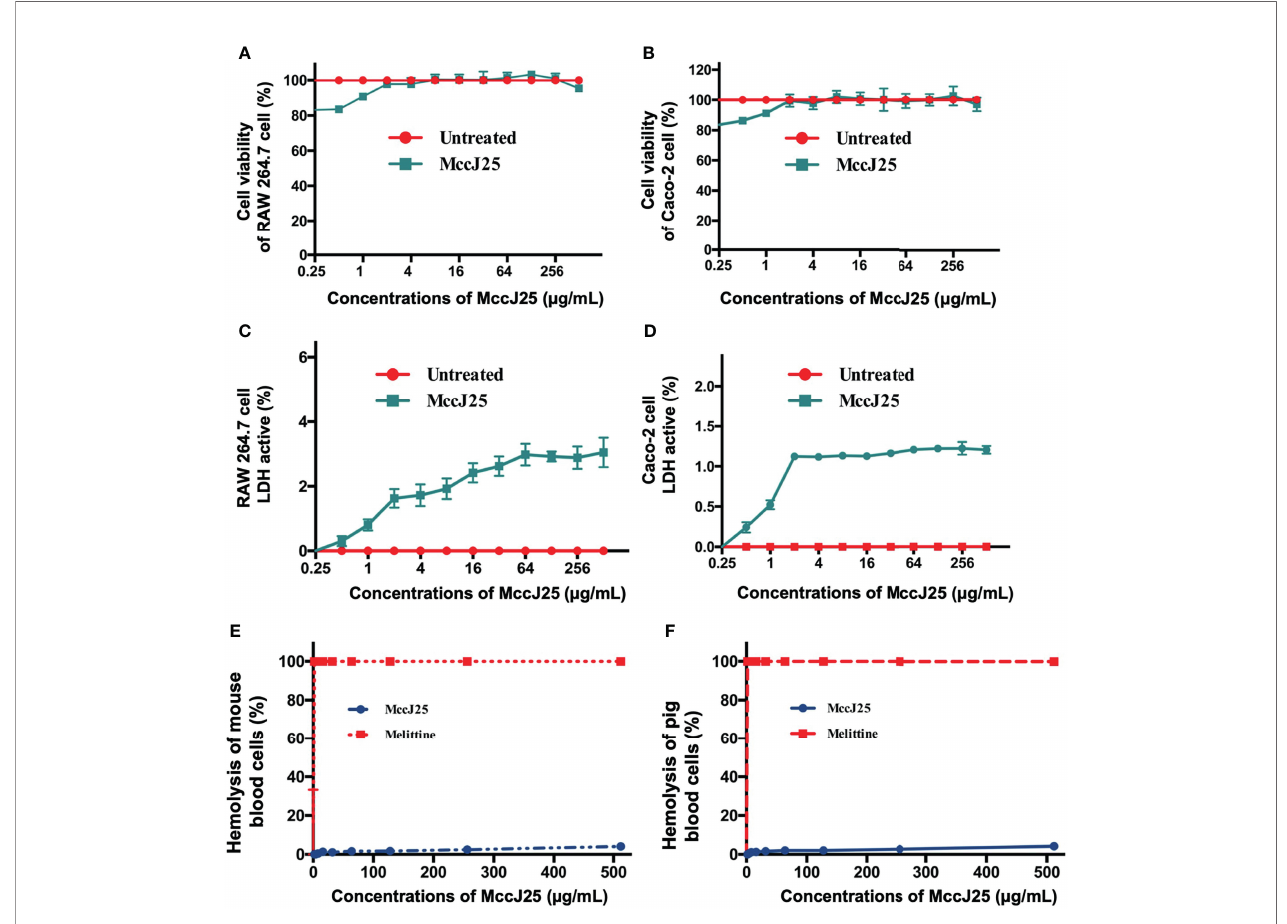
FIGURE 4 | MccJ25 shows no cytotoxicity. The effects of MccJ25 on the viability of RAW264.7 (A) and Caco-2 (B) cells. The effects of MccJ25 on LDH activity in RAW264.7 (C) and Caco-2 (D) cells. Hemolytic activities of MccJ25 against mouse red blood cells (E) and pig red blood cells (F) compared with those of melittin. Error bars indicate mean ± standard error of mean. Mean values are presented from 6 biological